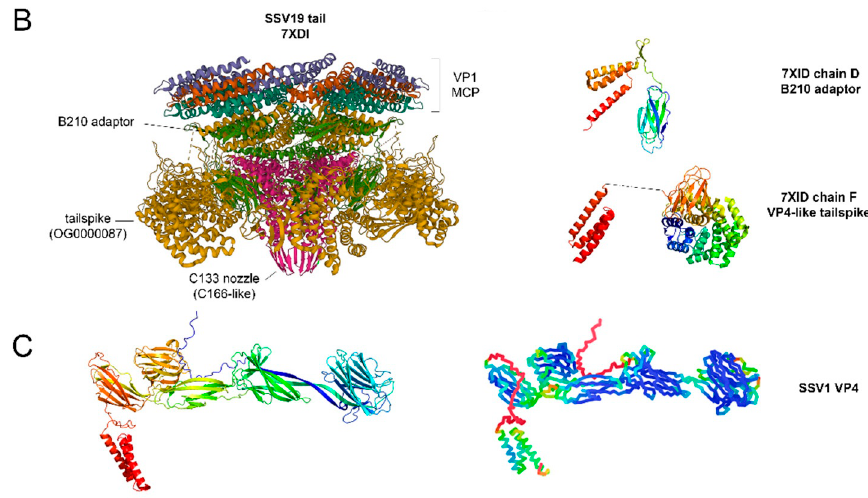
Figure 4. Genomic map of SSV1. ( A ) ORFs in the genome of SSV1 are depicted as arrows blocks, and coloring corresponds to their classification as part of the soft-core (red), cloud (yellow), or variable (purple) genome. Proteins expressed during lysogeny are marked with an asterisk (*). Inner arrows represent the transcripts of SSV1, and the font color indicates their classification according to their transcriptional profile into UV-induced (blue), early (green), late (orange), and late-extended (red) transcripts. Tlys is transcribed in the lysogenic state. Crystallographic structures available for SSV1 open-reading frames are depicted for the integrase D355, F93, D63, F112, A100, B129, and C166 (from the SSV19 homolog C131). The structures of VP1, VP2, VP3 ( A ), and VP4 ( C ) were modelled using AlphaFold2 [53]. ( B ) Cryo-electron micrograph of the SSV19 tail (7XID, [38]). The atomic models of the B210 adaptor and the VP4-like tail-spike are shown to the right. ( C ) Model structure of SSV1 VP4. Left: atomic model of SSV1 VP4. Right: model colored according to the confidence measure of the prediction (pLDDT) on a scale from 0 to 100, where blue indicates high confidence and red indicates low confidence.